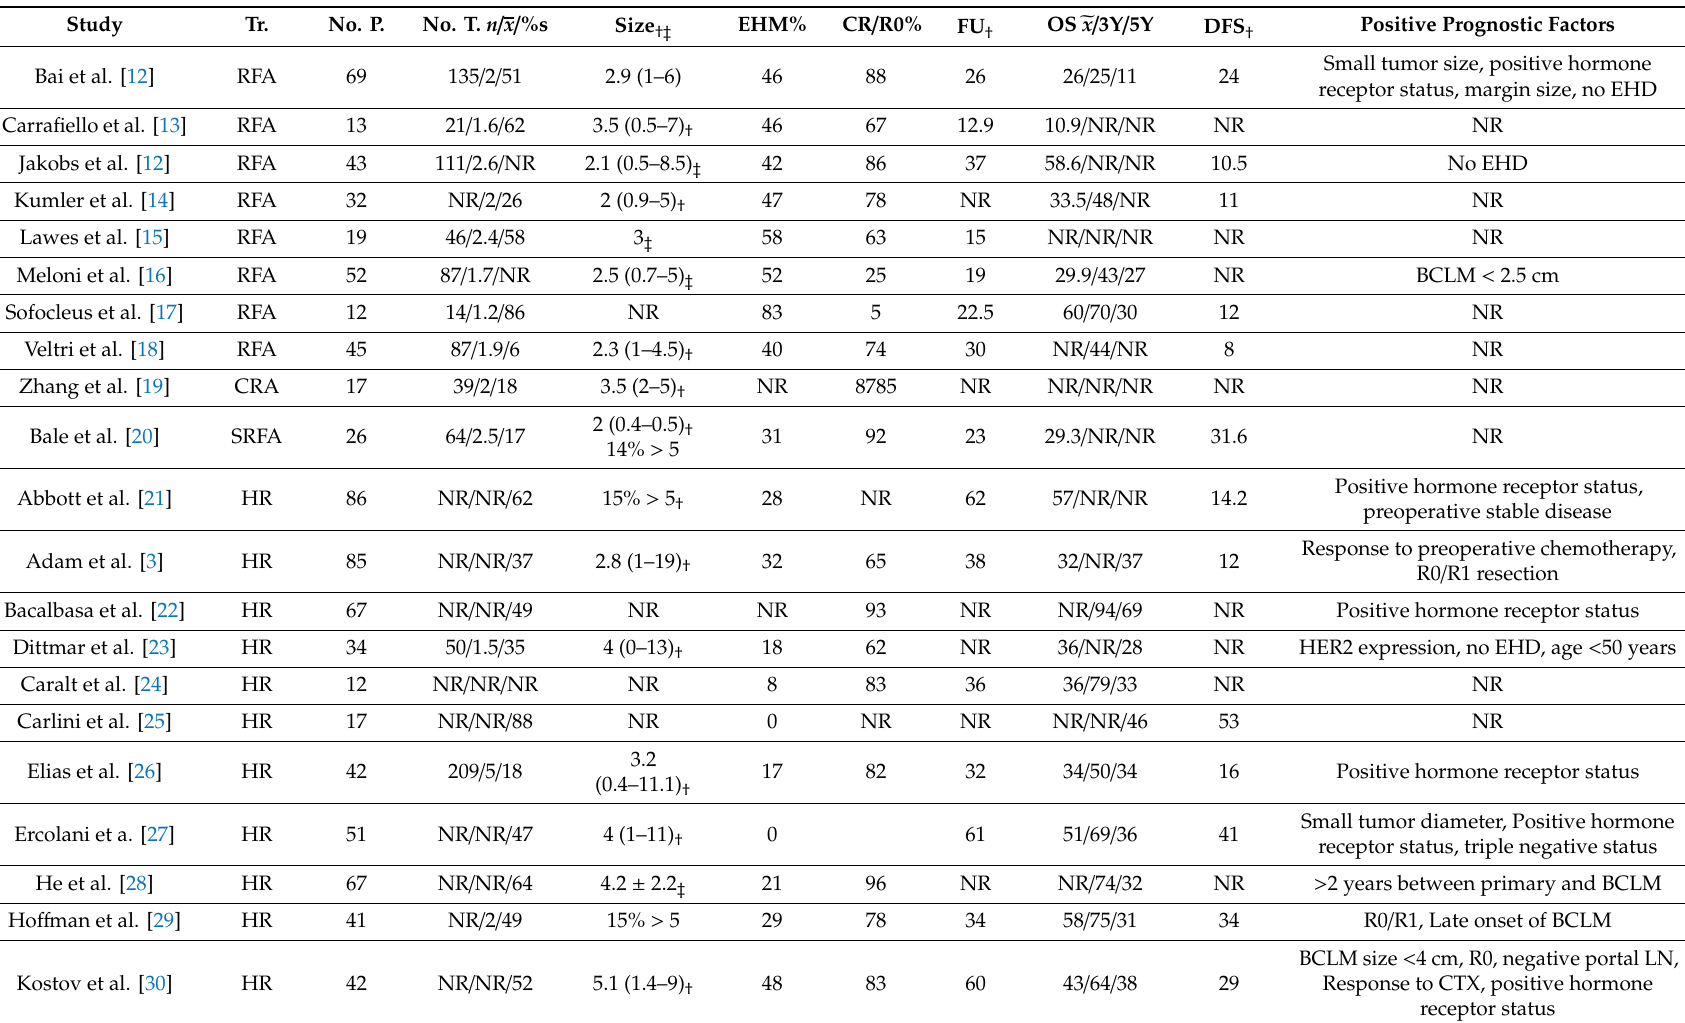
Table 1. Studies included for systematic review showing key study